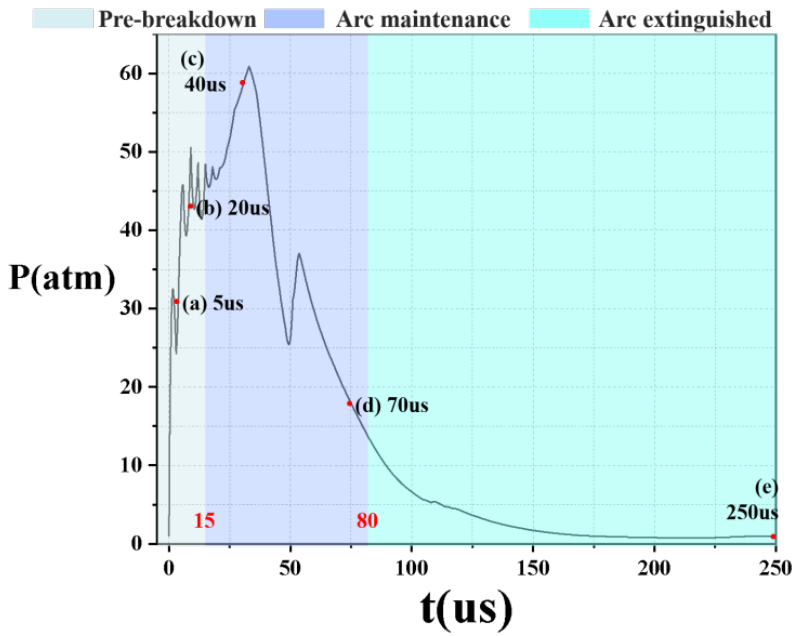
Figure 5. Simulation curve of pressure change.